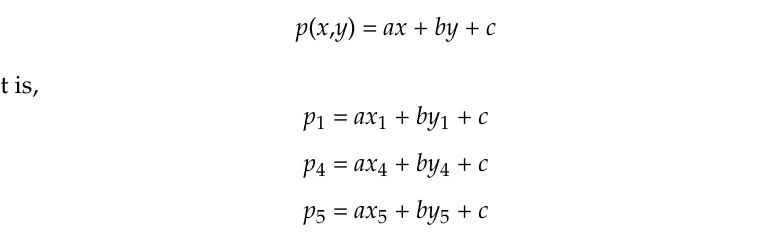
Figure 7. Linear interpolation of pressure and flow conservation at interface.